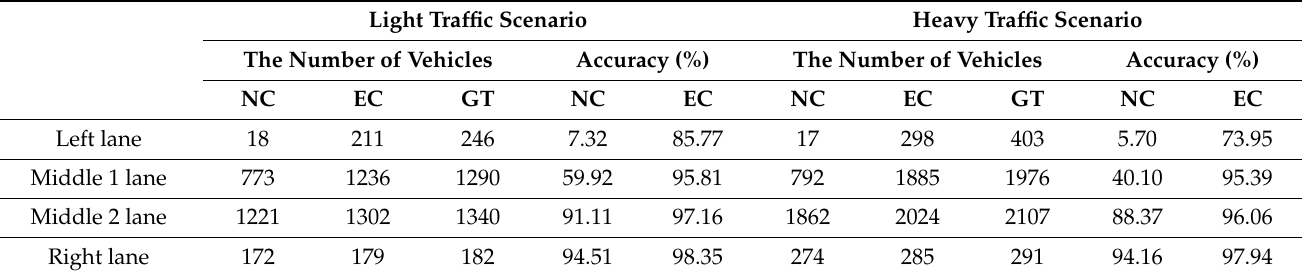
Table 3. Vehicle count and accuracy for different lanes in light and heavy traffic scenarios. NC represents YOLO results without vehicle localization error correction, CC means YOLO results with the vehicle localization error correction, and GT is the ground